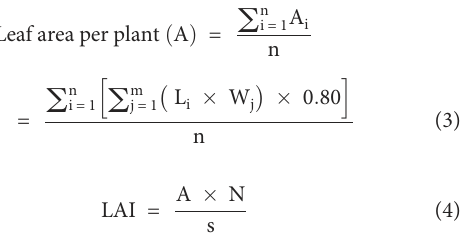
TABLE 1 Experimental treatment labels with different irrigation scheduling and nitrogen application modes. Treatment